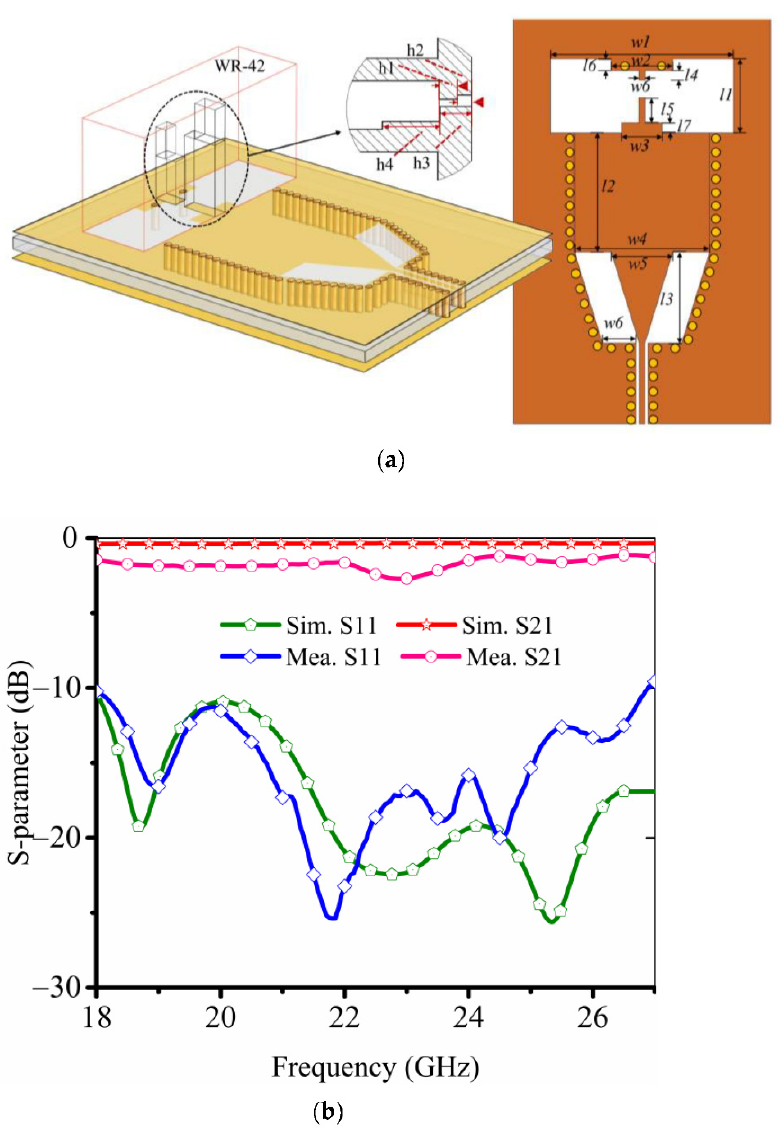
Figure 6. Configuration of the proposed SIW cavity. ( a ) Geometry of the SIW-to-waveguide transition structure. ( b ) Simulated and measured S11, S21 (w1 = 10.668, w2 = 3.6, w3 = 2.36, w4 = 7.87, w5 = 3.59, w6 = 2.14, l1 = 4.318, l2 = 17.4, l3 = 5.3, l4 = 0.57, l5 = 1.47, l6 = 0.7, l7 = 0.58, h1 = 1.64, h2 = 1.24, h3 = 2.8, h4 = 5.13. Unit: mm).